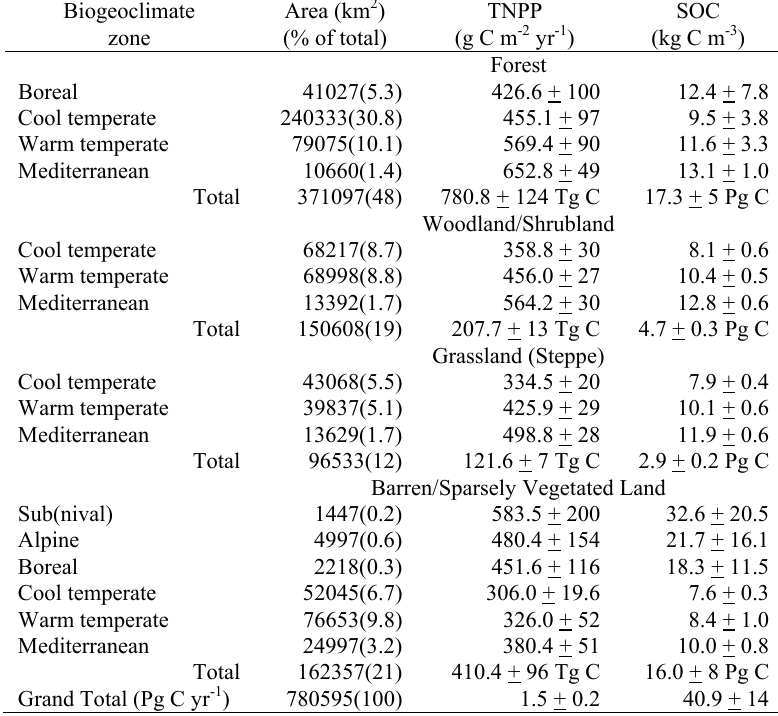
Table 5. Total net primary productivity (TNPP, g C m -2 yr -1 ) and soil organic carbon (SOC, kg C m -3 ) density (0 to 100 cm in depth) under optimal conditions based on Miami model modified by Friedlingstein et al. [42]. Biogeoclimate Area (km 2 ) TNPP zone